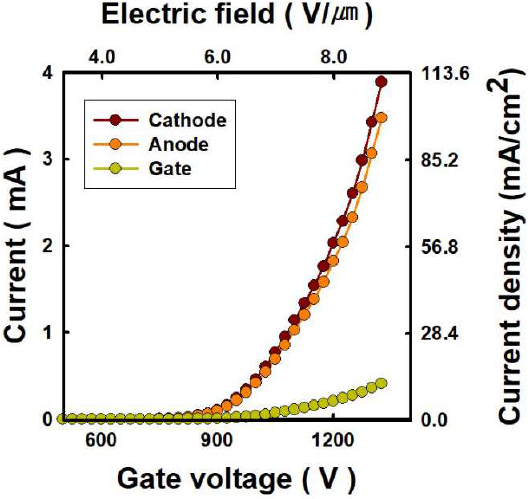
Figure 2. Current-voltage characteristics of carbon nanotube-based cold cathode electron beam. The anode is biased at 10 kV .